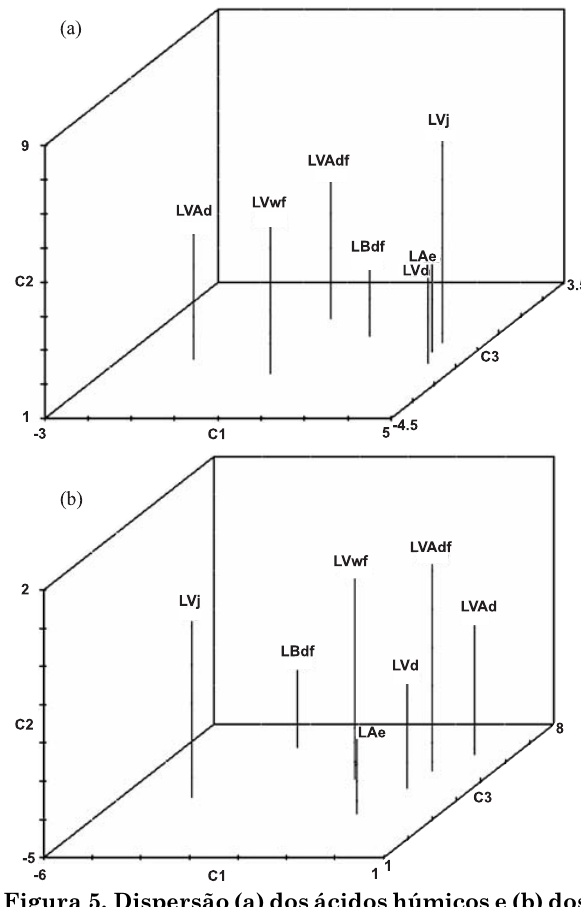
Figura 5. Dispersão (a) dos ácidos húmicos e (b) dos ácidos fúlvicos isolados dos Latossolos em relação aos seus escores, nos três primeiros componentes